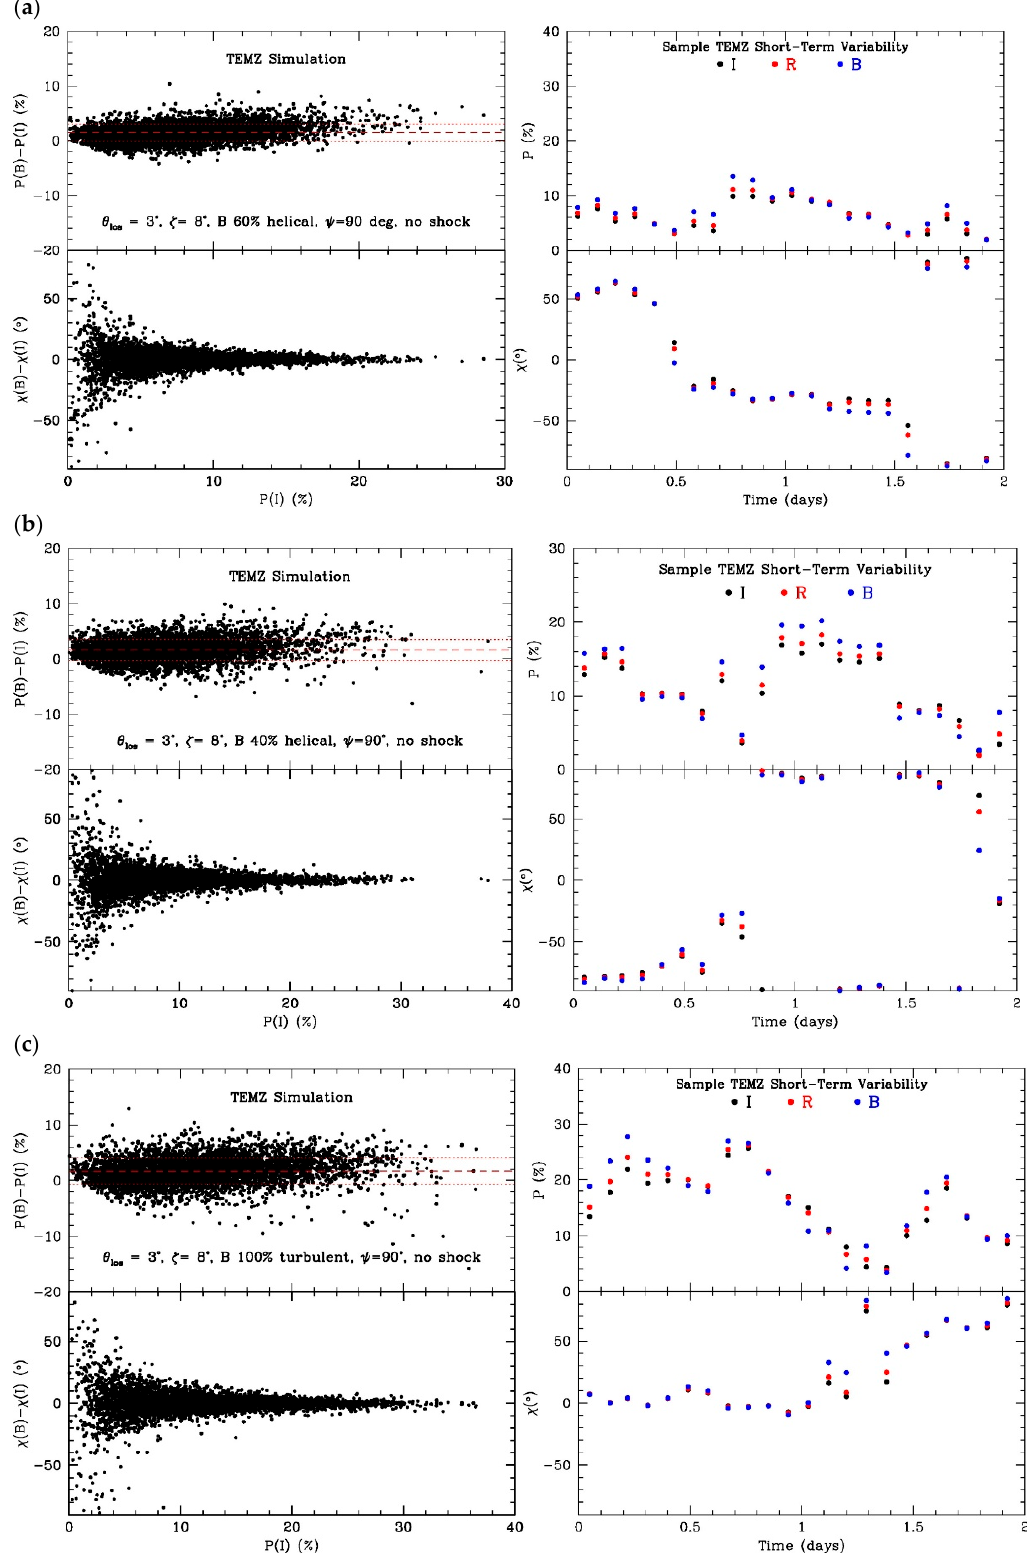
Figure 3. Similar to Figure 2 for the case of a turbulent jet without a shock and for only three ratios of helical to total magnetic field: ( a ) 60%, ( b ) 40%, and ( c ) 0% (100% turbulent